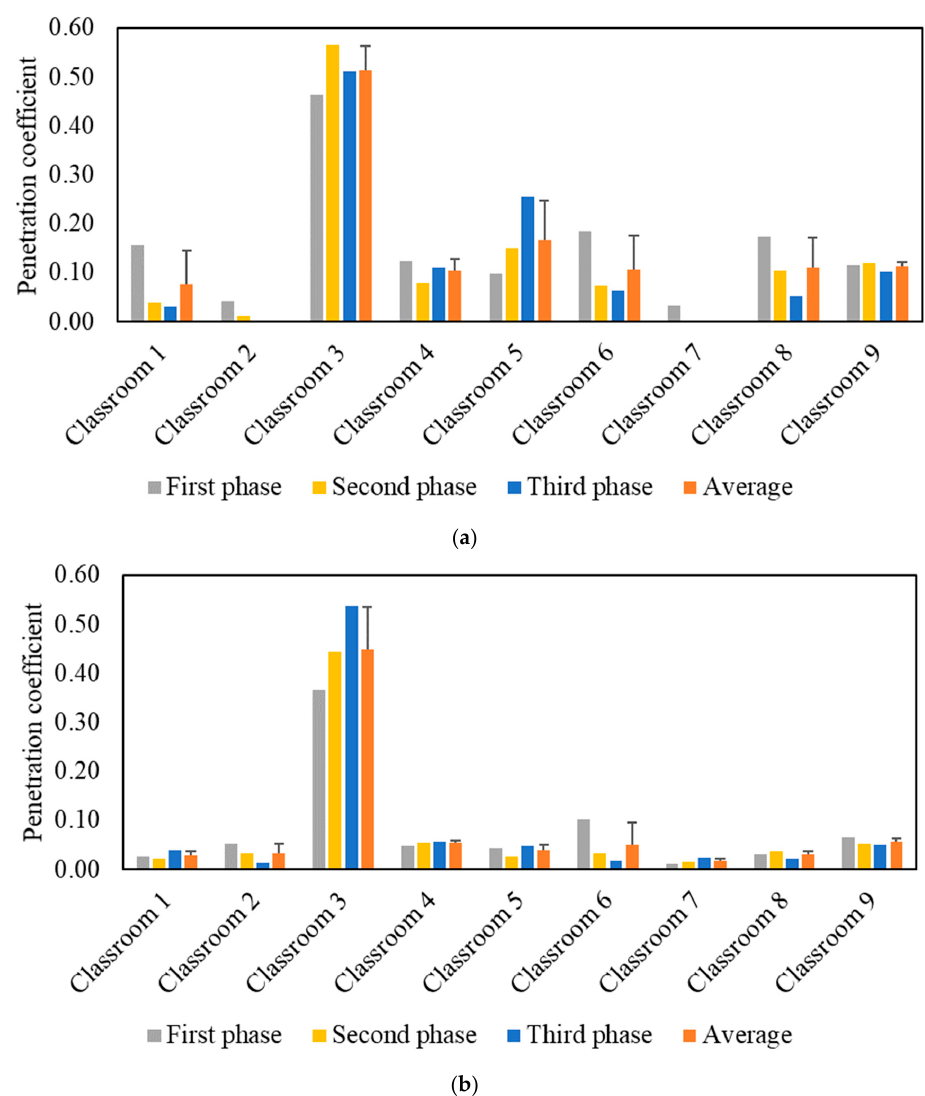
Figure 4. Particle indoor penetration based on: ( a ) PM 2.5 mass concentration and ( b ) particle number concentration. The error bars indicate standard deviations of the values measured on three different days.